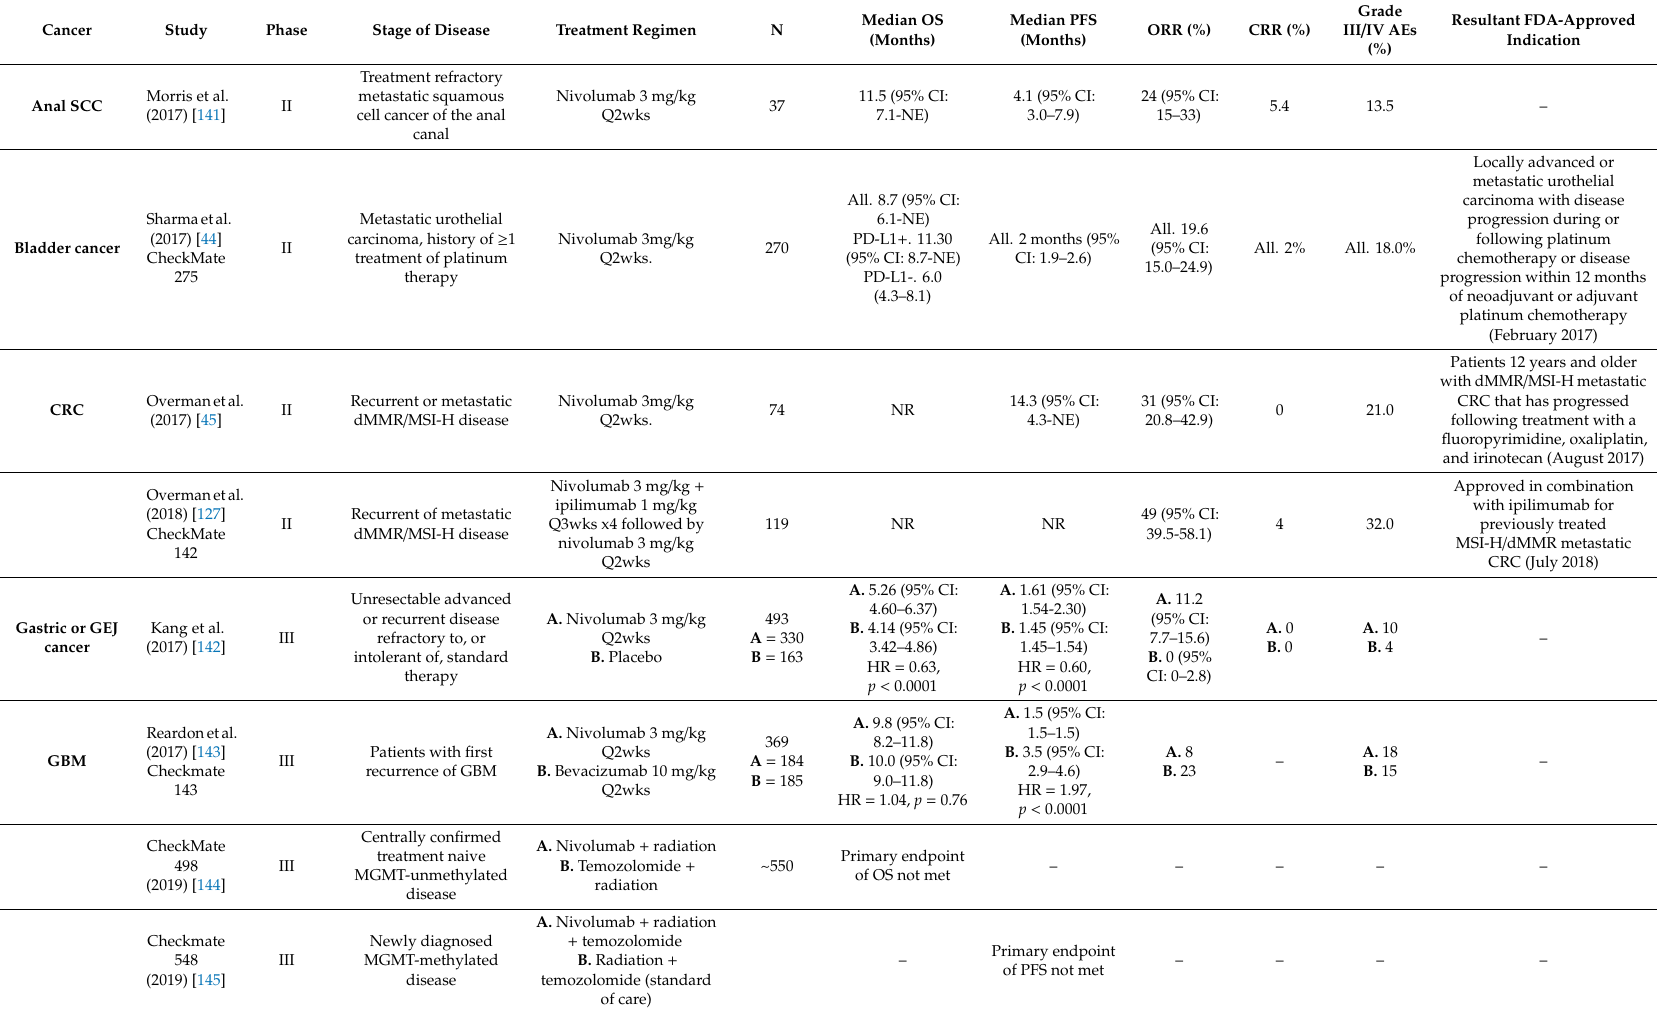
Table A3. Select clinical data for